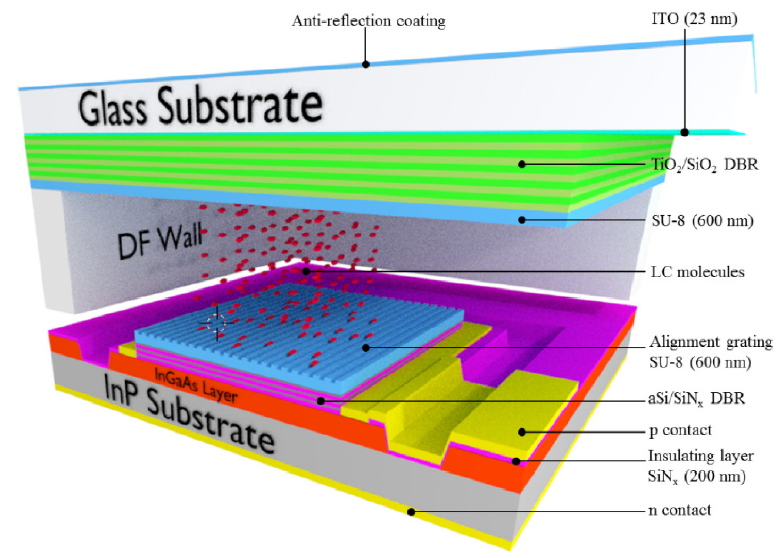
Figure 12. Three-dimensional and cross-section view for a single tunable PD [72]. Reprinted with permission from Ref. [72]. 2018 The Optical Society.